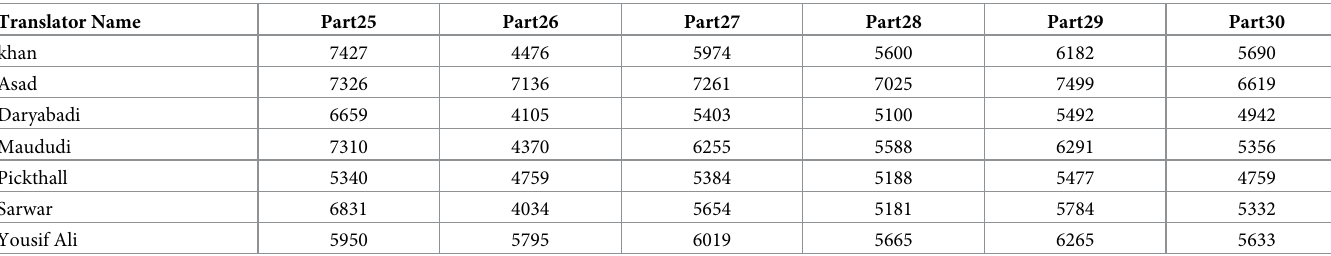
Table 1. Number of words in the dataset for each translator of the Holy Qur’an. Translator